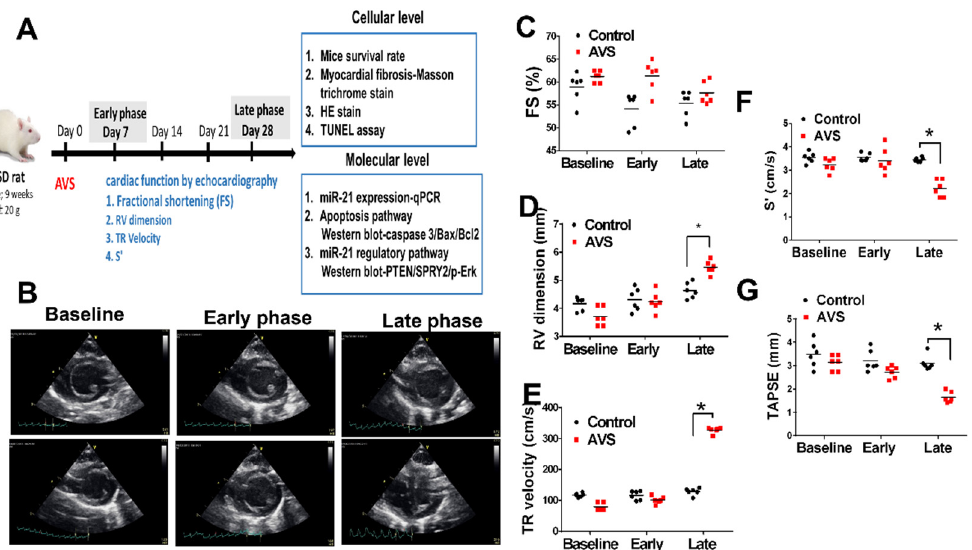
Figure 1. Right ventricular (RV) dysfunction in the late phase of arteriovenous shunt- (AVS) induced pulmonary arterial hypertension (PAH) in rats ( A ) Schematic diagram of AVS-induced PAH in Sprague–Dawley rats in early (7 days) and late (28 days) phases. ( B ) The echocardiography follow-up in rats of the control and AVS groups in early and late phases. Echocardiographic measurements of ( C ) left ventricular fractional shortening (FS), ( D ) RV dimension, ( E ) tricuspid regurgitation (TR) velocity, ( F ) S’ and ( G ) tricuspid annular plane systolic excursion (TAPSE). * p < 0.05 for difference between each group. (N = 6–8).